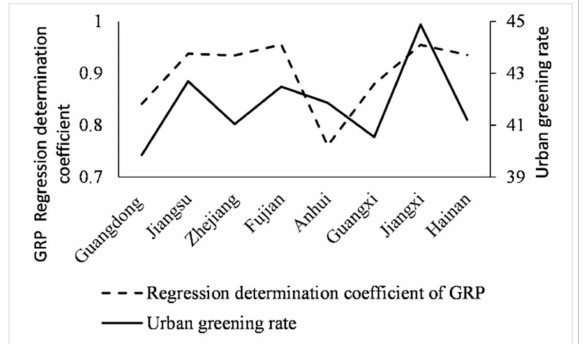
Figure 11. Comparison of GDP regression R 2 and urban green rate curve in southeast